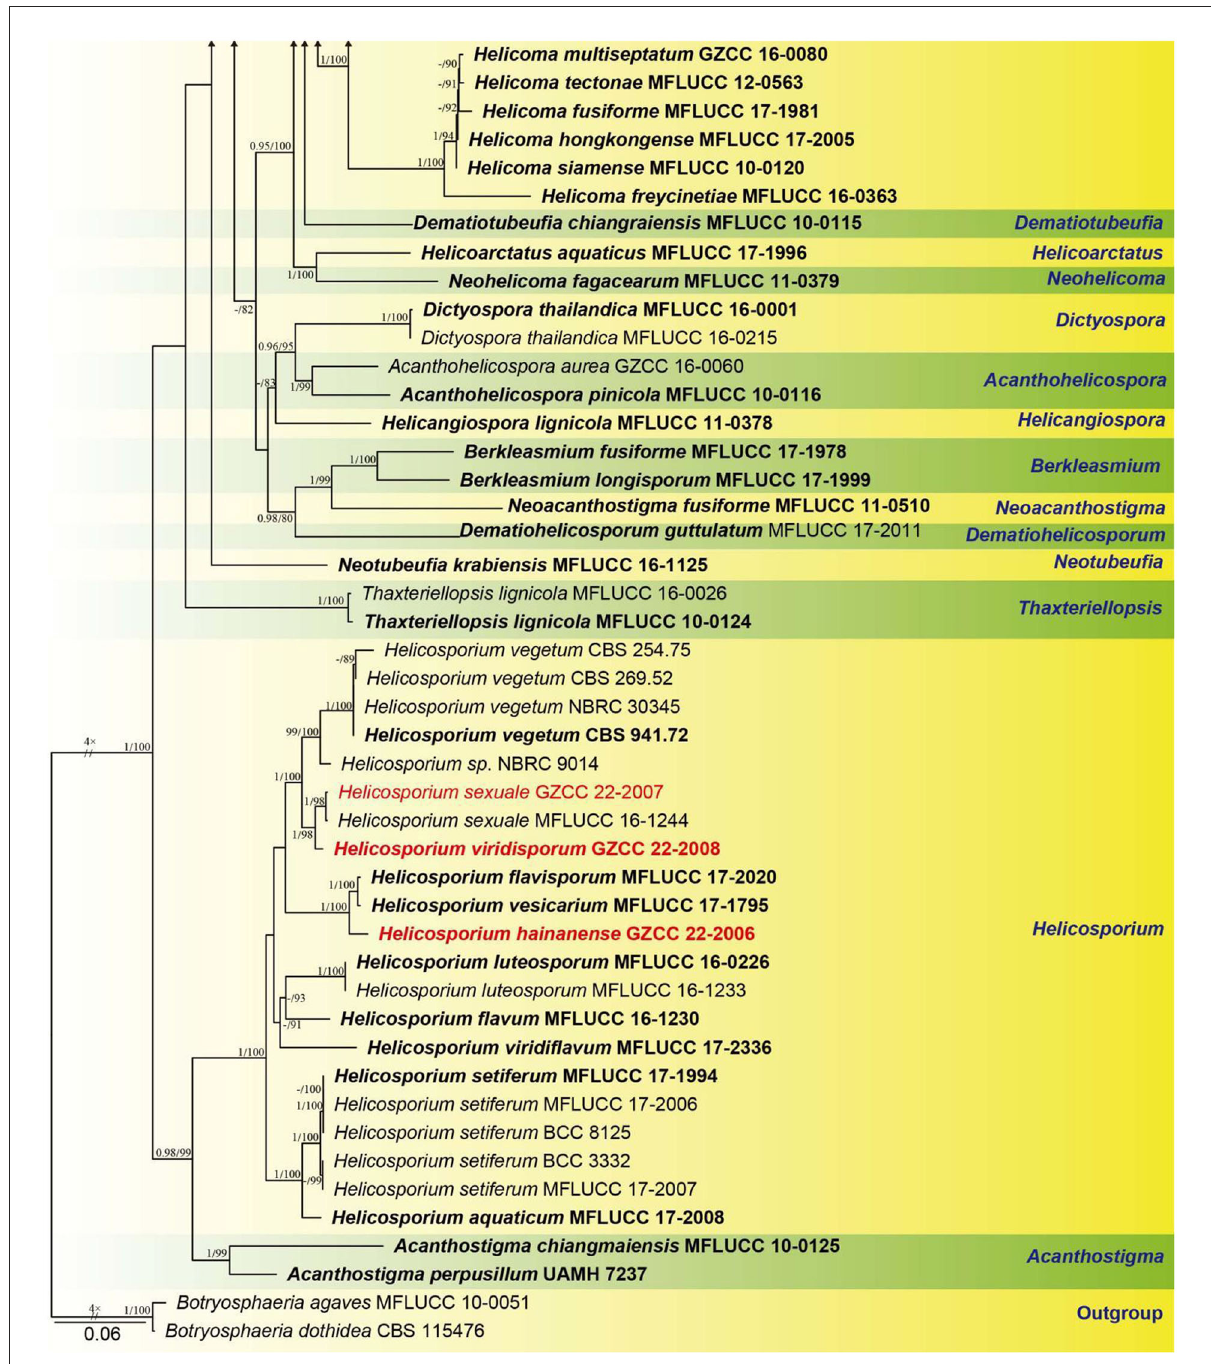
FIGURE2 Phylogenetic tree generated from a maximum likelihood analysis based on a concatenated alignment of ITS, LSU, RPB2, and TEF1 α sequence data. Bootstrap support values of maximum likelihood (ML) ≥ 75% and Bayesian posterior probabilities (PP) ≥ 0.95 are given near the nodes as PP/MLBS. The tree is rooted with Botryosphaeria agaves (MFLUCC 10-0051) and B. dothidea (CBS 115,476). Newly generated sequences are in red. Ex-type strains are in